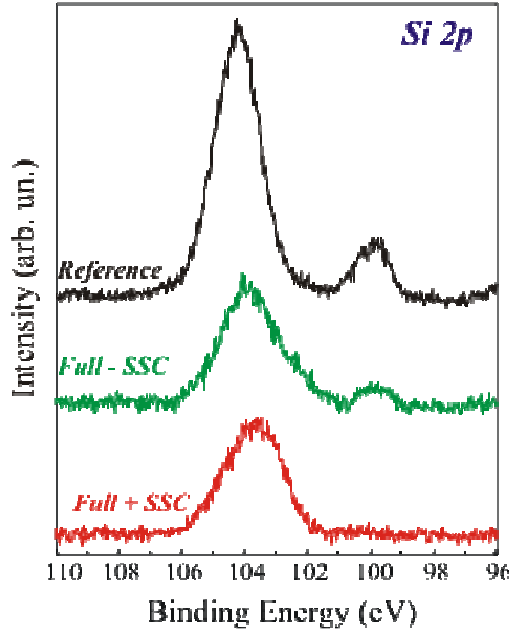
Figure 3. High acquisition mode XPS Si2 p spectral region of the reference (black line), fully processed without SSC (green line, Full-SSC) and fully process with SSC (red line)